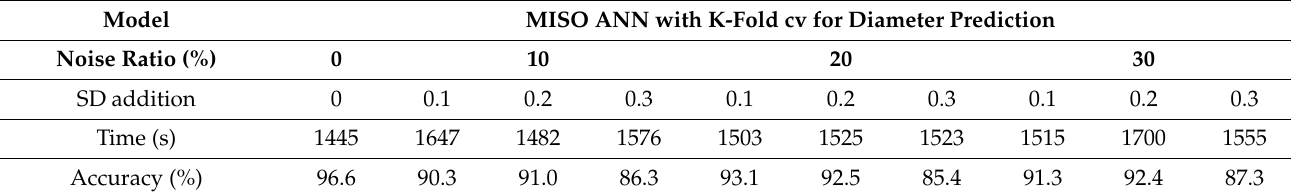
Table 18. Statistical tests of MISO ANN with K-fold cv model for diameter prediction. MISO ANN with K-Fold cv for Diameter Prediction